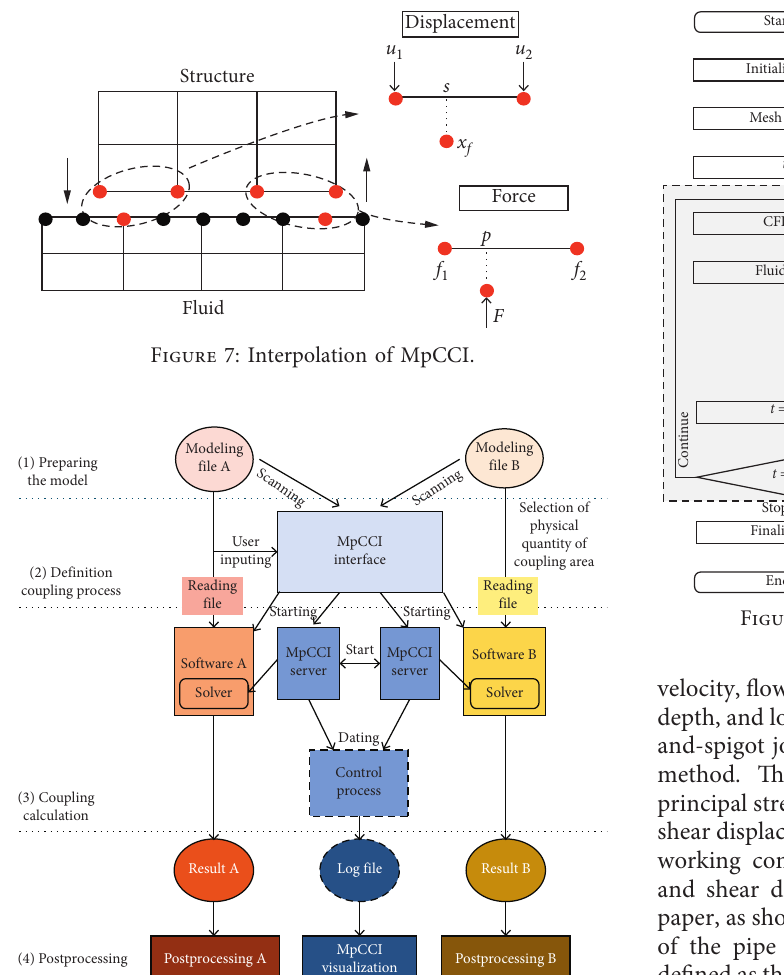
Figure 8: The calculation process of MpCCI.